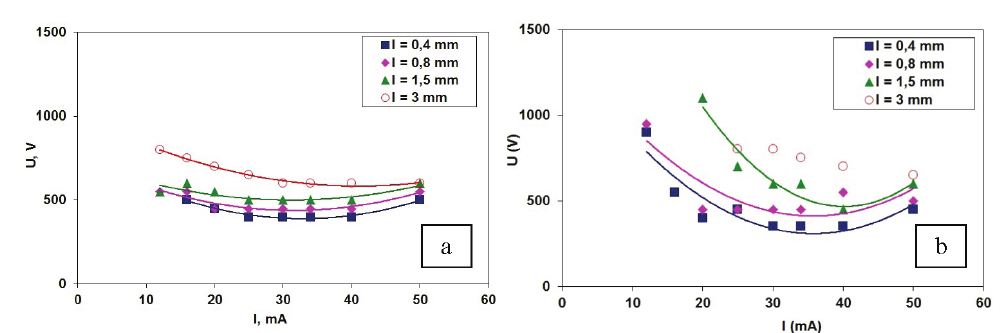
Figure 2: The CVC of the microdischarge with vortex gas flow for different interelectrode gaps and polarities of the flat electrode: а) positive; b) negative. Diameter of the gas outlet is d = 0.5 mm. Air flow is G = 2 L min -1 .